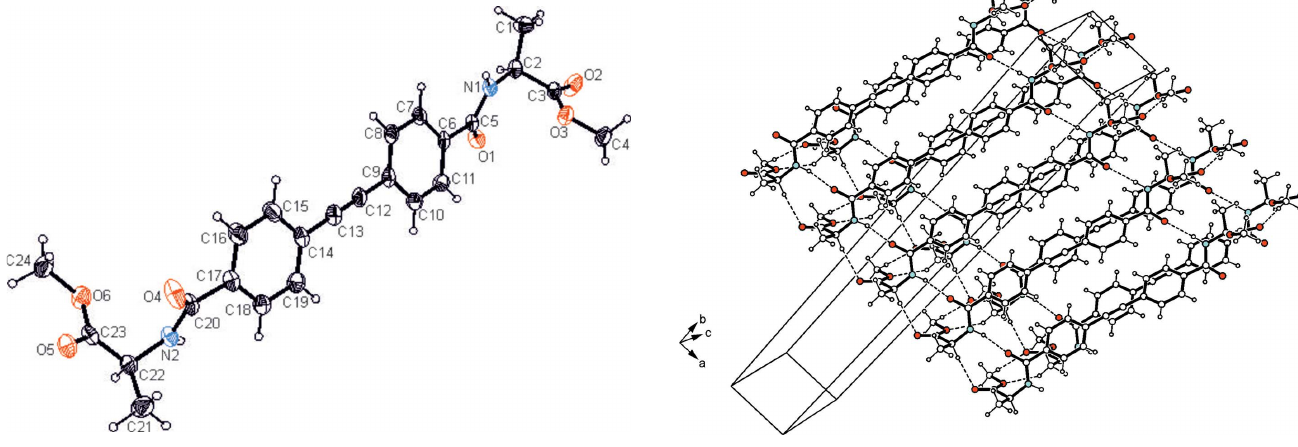
Figure 1 Perspective view of the molecular structure of the title compound with the atom labeling. Displacement ellipsoids of non-H atoms are shown at the 50% probability